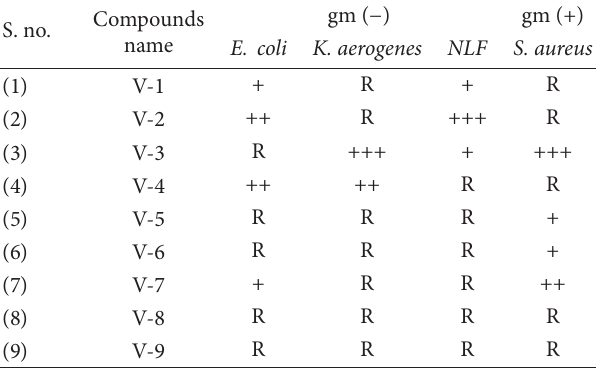
T 2: Antibacterial activity of compounds V-1 to V-9